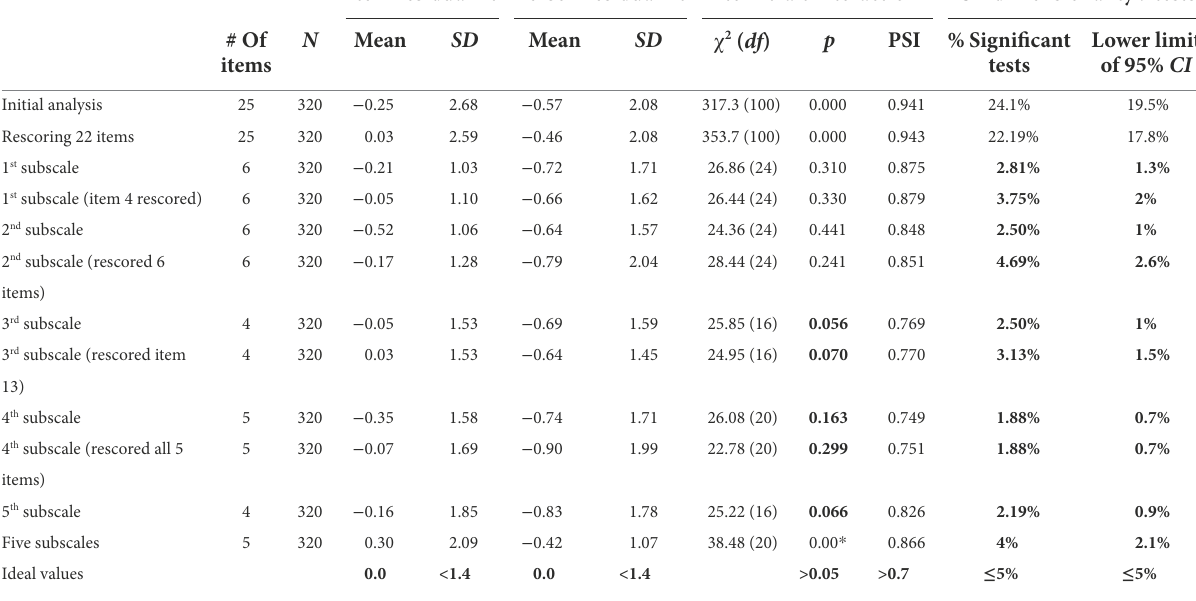
TABLE 1 Rasch analysis statistics at each